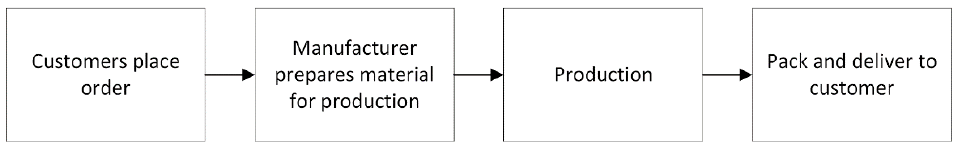
Figure 1. The process from customer order to delivery. Adapted with permission from Ref. [7]. Copyright 2016 Łukasz Wiechetek.